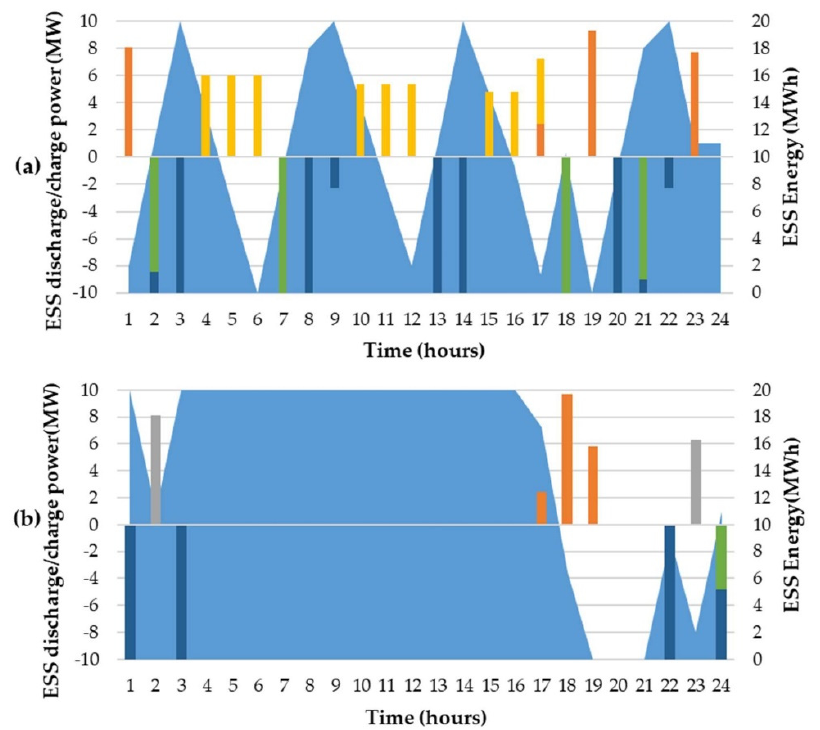
Figure 9. The ESS operational scheduling with scenario p 1 of the reserve probability: ( a ) The reserve bid is called on to produce; ( b ) the reserve bid is not called on to produce